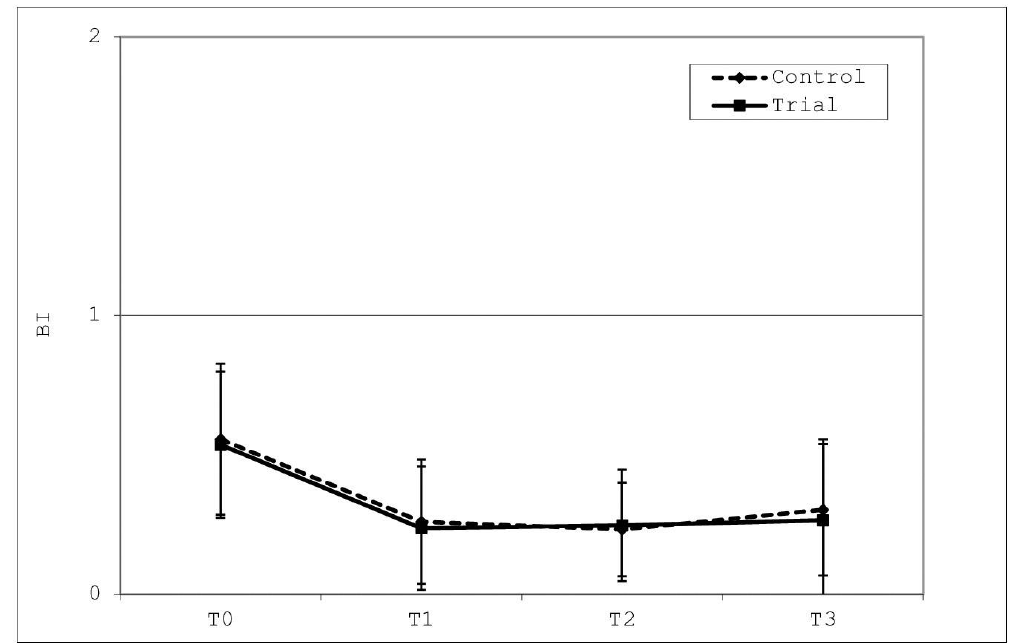
Figure 2. Bleeding index (BI). Mean and standard deviation of the BI in the intervention and control group. Table 2. Descriptive statistics of BI results.